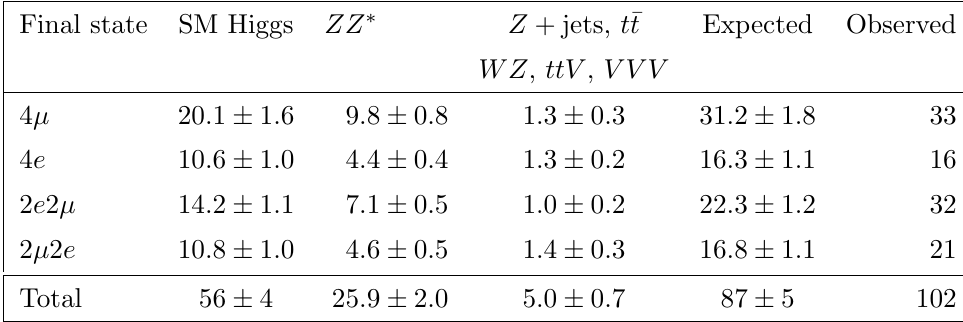
Table 2. Number of expected and observed events in the four decay channels after the event selection, in the mass range 115 GeV < m 4 ‘ < 130 GeV. The sum of the expected number of SM Higgs boson events and the estimated background yields is compared to the data.